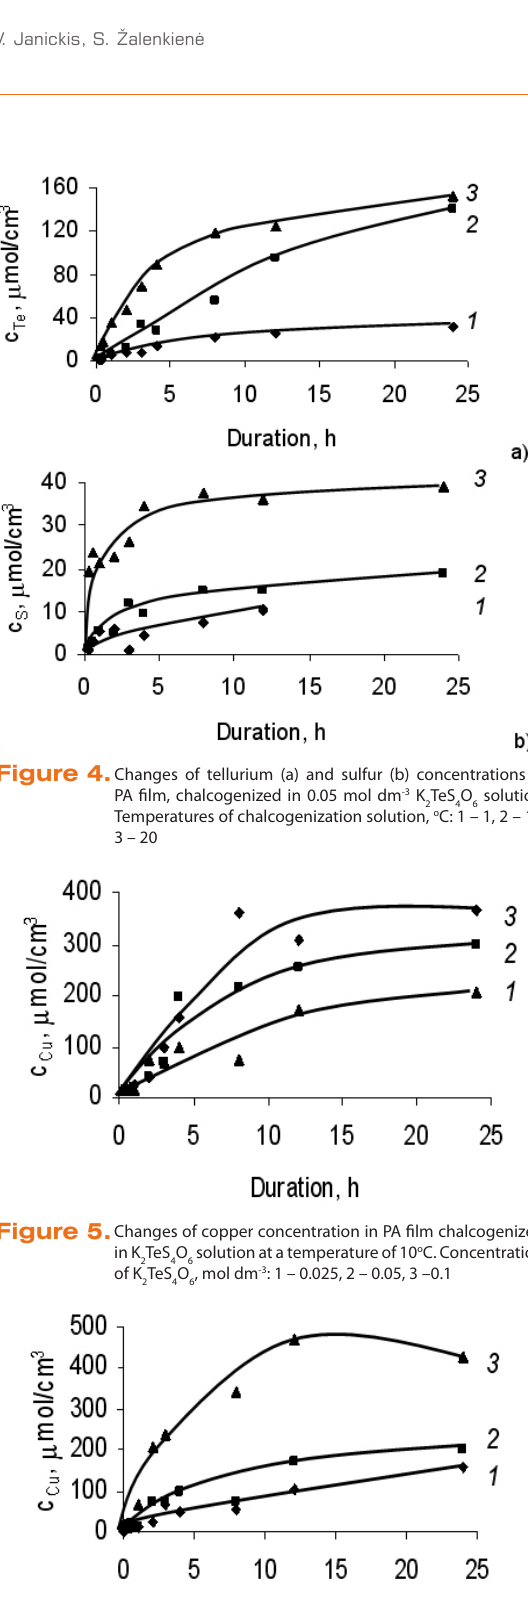
Figure 6. Changes of copper concentration in PA film